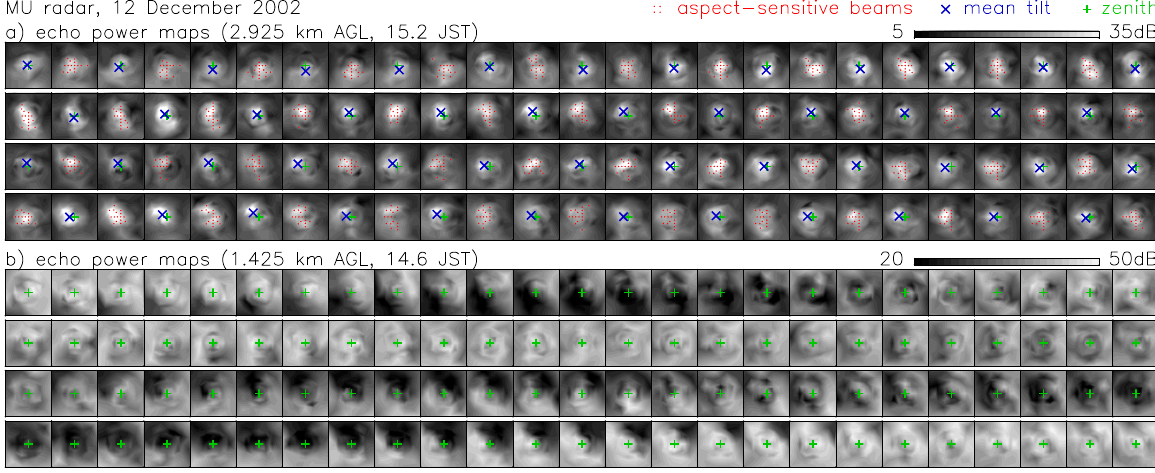
Fig. 4. Horizontal maps of clear-air echo power at heights of ( a ) aspect-sensitive and ( b ) convective echoes. Alternate maps in (a) are overplotted with radar beam directions of increased echo power caused by aspect sensitivity (groups of red dots), and mean echo-power tilt from these beams (blue × ). Time step is 6.55s, starting top-left, north is at the top of each plot, zenith is marked as green + , and horizontal width is (a) 1460m, (b)